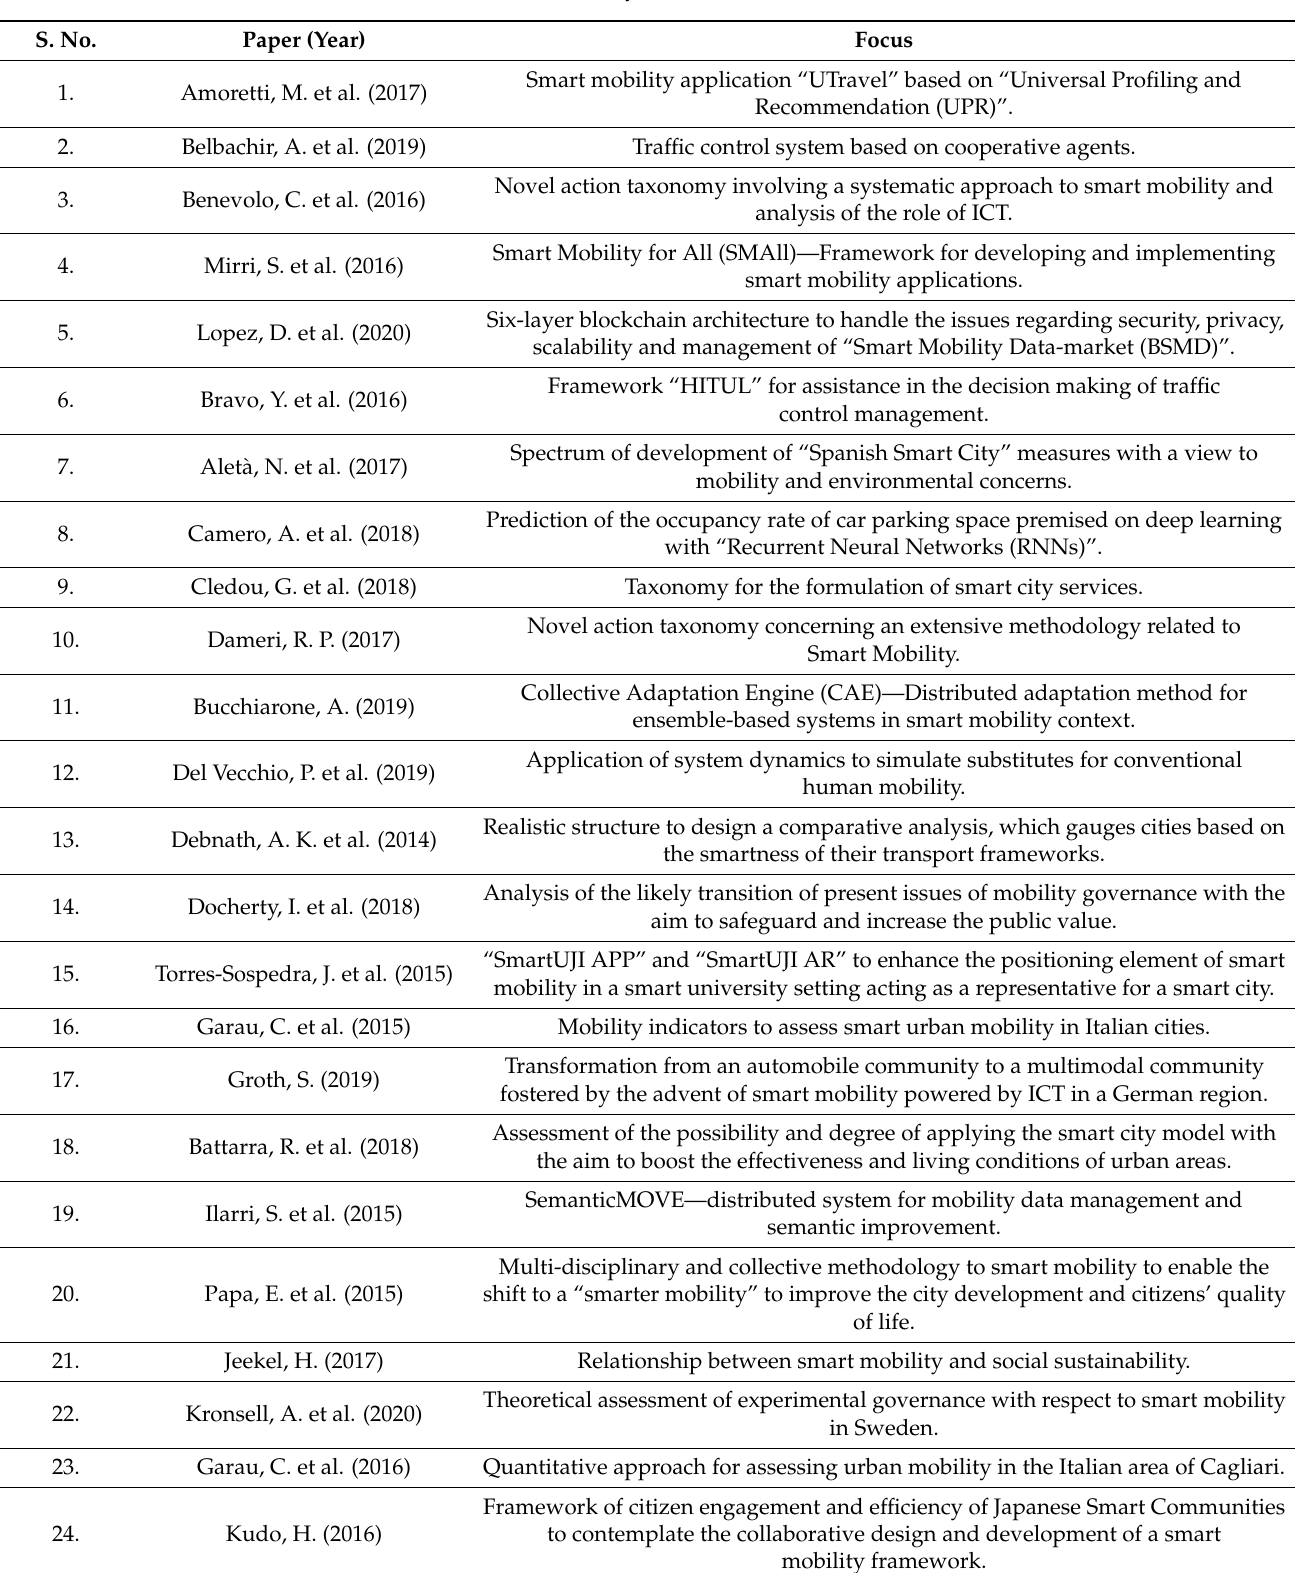
Table 1. Summary of literature